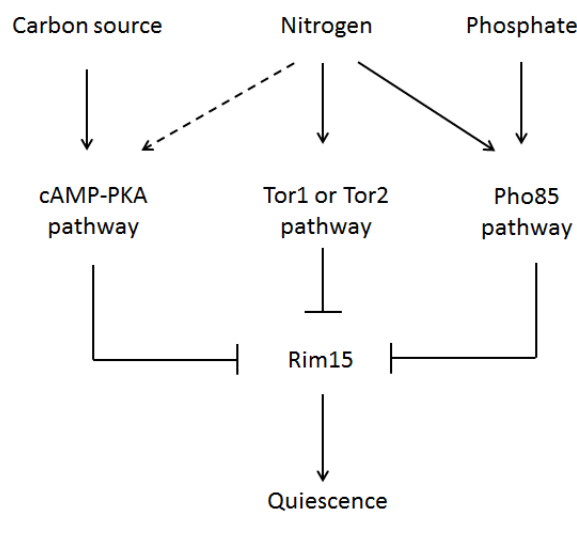
FIGURE 2: Cell cycle control by nutrients in S.